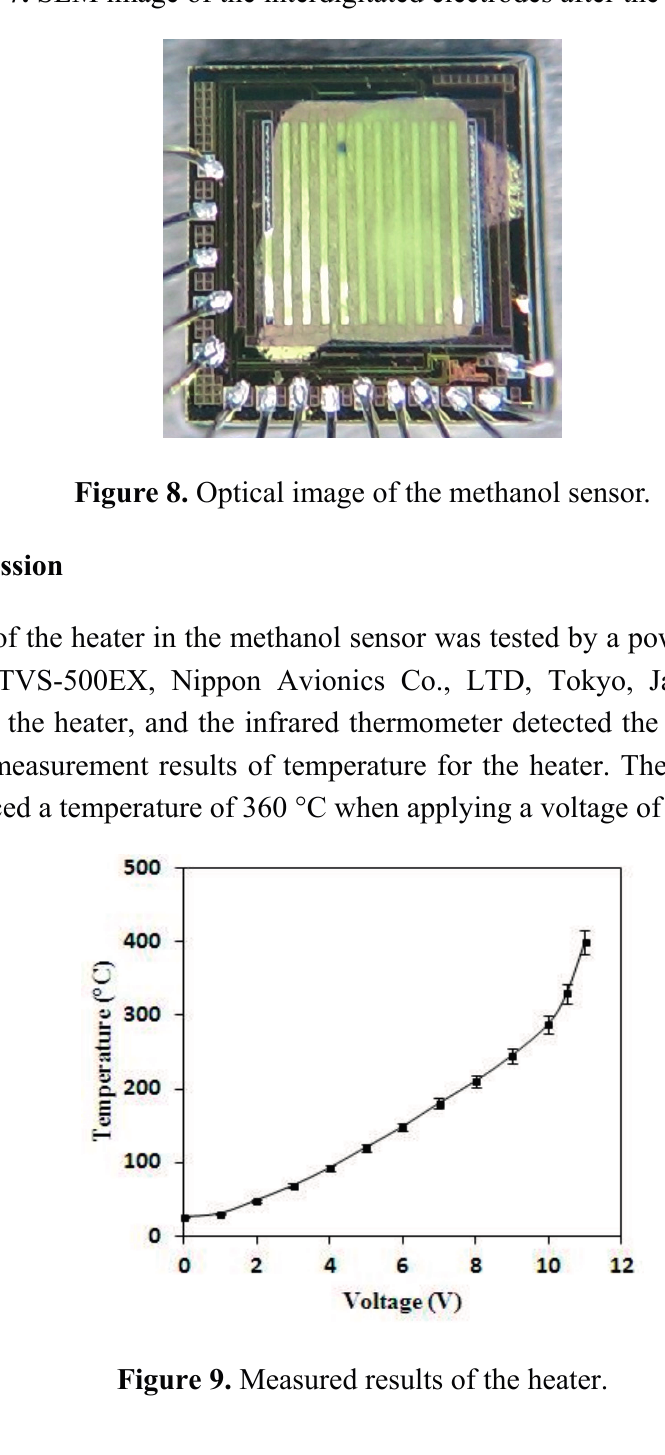
Figure 7. SEM image of the interdigitated electrodes after the dry etching.